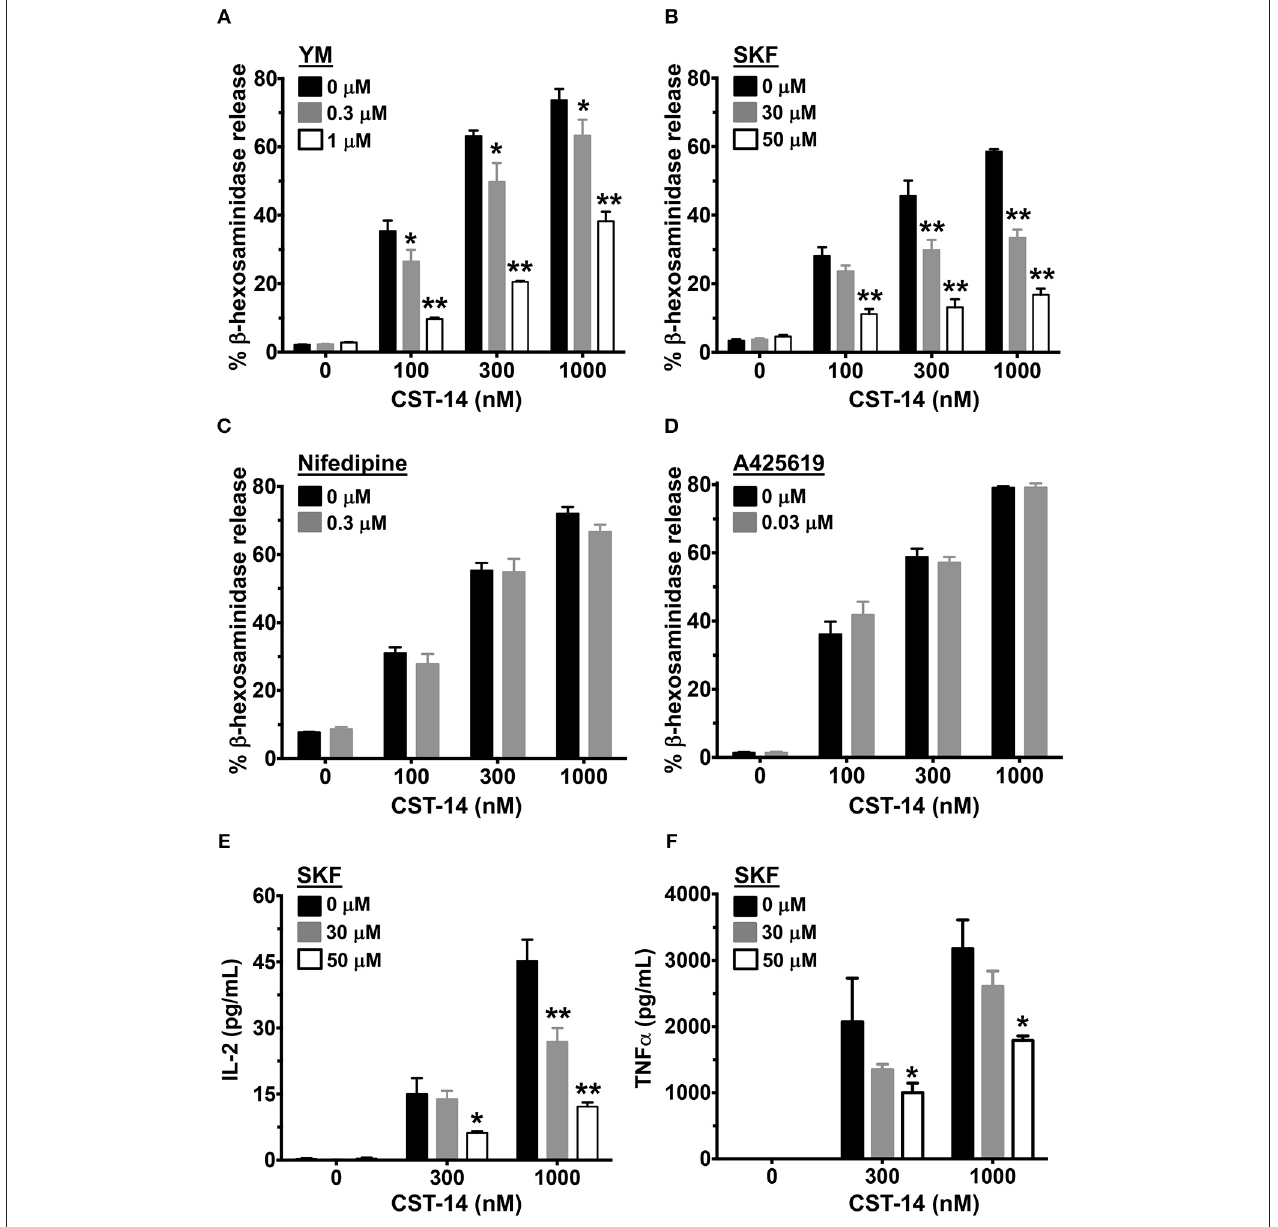
FIGURE 2 | Mast cell degranulation and cytokine production are inhibited by SOCE antagonists. (A–D) CST-14-induced degranulation in LAD2 mast cells as quantified by β -hexosaminidase release in the presence of (A) YM, (B) SKF, (C) Nifedipine, and (D) A425619 is shown. Values are plotted as percentages of total cell lysate β -hexosaminidase content. (E,F) Bar graphs show IL-2 and TNF- α production by LAD2 mast cells stimulated with the indicated concentrations of CST-14. Data shown are mean ± S.E. of 3–5 independent experiments. Statistical significance was determined by two-way ANOVA. * p < 0.05 and ** p < 0.01.